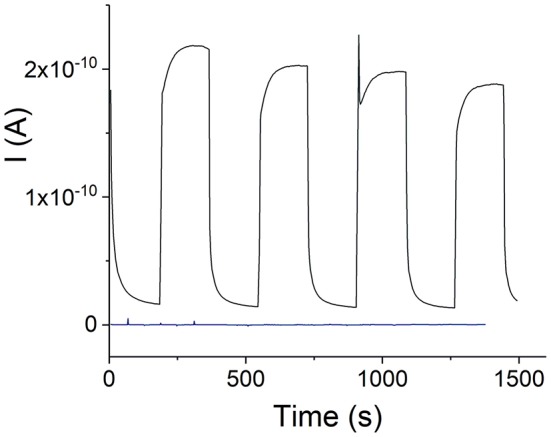
Visible light photoresponse of the H4TPPS42--SnTPyP4+ nanotubes prepared in an equimolar solution at pH 2, electrode gap 400 nm, Vapp = 0.5 V. A dark blue curve shows a visible light photoresponse of a device with no nanostructures. The device was prepared by dropcasting an equimolar solution of TPPS4 and SnTPyP4+ (pH 6) onto the chip as described in experimental section Electrophotoresponse Measurements.